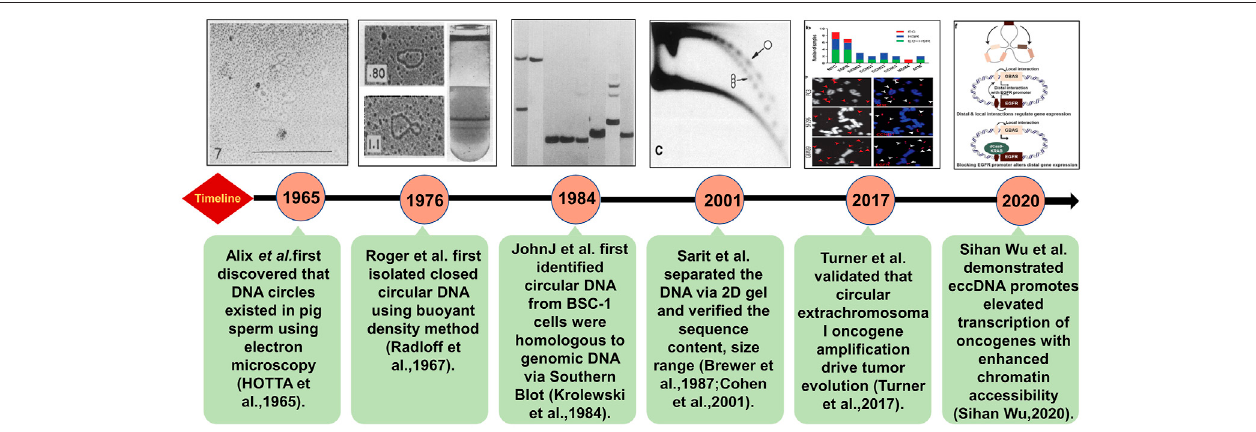
FIGURE 1 | Brief discovery history of eccDNA. The technologies and key discoveries were illustrated following the timeline of the milestone studies. The detailed descriptions areasfollowing: in1965,AlixBasseland YasuoHoota fi rstobservedeccDNAs inboarsperm undertheelectron microscope(Hottaand Bassel,1965).The Roger ’ s group extracted eccDNA in HeLa cells by CsCl gradient puri fi cation in 1976 (Radloff et al., 1967). In 1984, Krolewski found that eccDNA molecules were homologous to genomic DNA (Krolewski et al., 1984) using Southern blot indicating that eccDNAs may be derived from chromosomes. Neutral – neutral two- dimensional (2D) gel electrophoresis combined with standard procedures of Southern blots and hydridization veri fi ed useful for characterizing eccDNA including its size rangeandsequencecontent,anditcanproveeccDNAorganizedasdiscretemultimers(BrewerandFangman,1987;CohenandMechali,2001).Withrapidadvancesin high-throughputDNAsequencing,moreeccDNAshavebeenidenti fi edandquanti fi edonagloballevel(Turneretal.,2017).Furthermore,thearchitectureofeccDNAcan be directly observed by super resolution (SR) confocal microscopy (Sihan Wu, 2020).